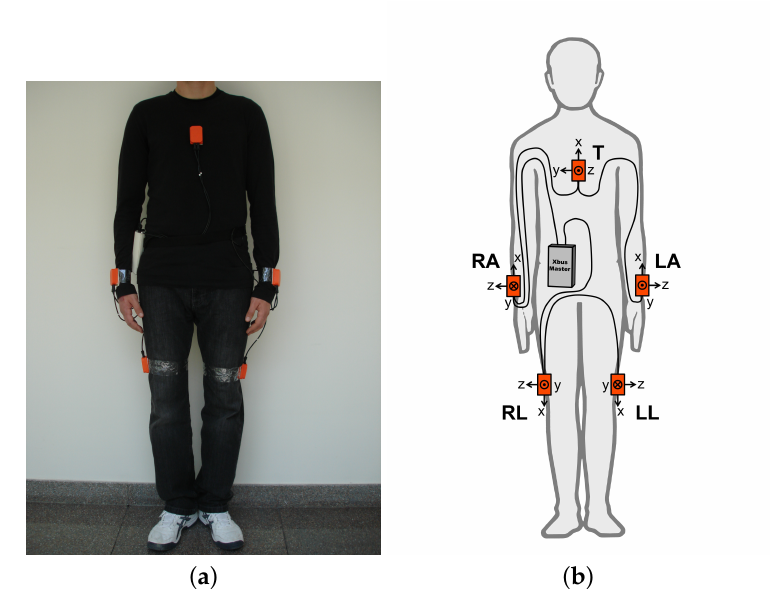
Figure 6. ( a ) Positioning of the MTx units on the body; ( b ) connection diagram of the units (the body drawing in the figure is from http://www.clker.com/clipart-male-figure-outline.html; the cables, Xbus Master, and sensor units were added by the